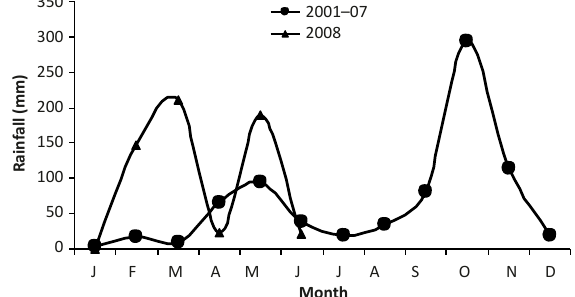
Figure 1. Rain fall status recorded for Thengumarahada Village from 2001 to 2008. (Source: Public Works Department, Govt. of Tamil